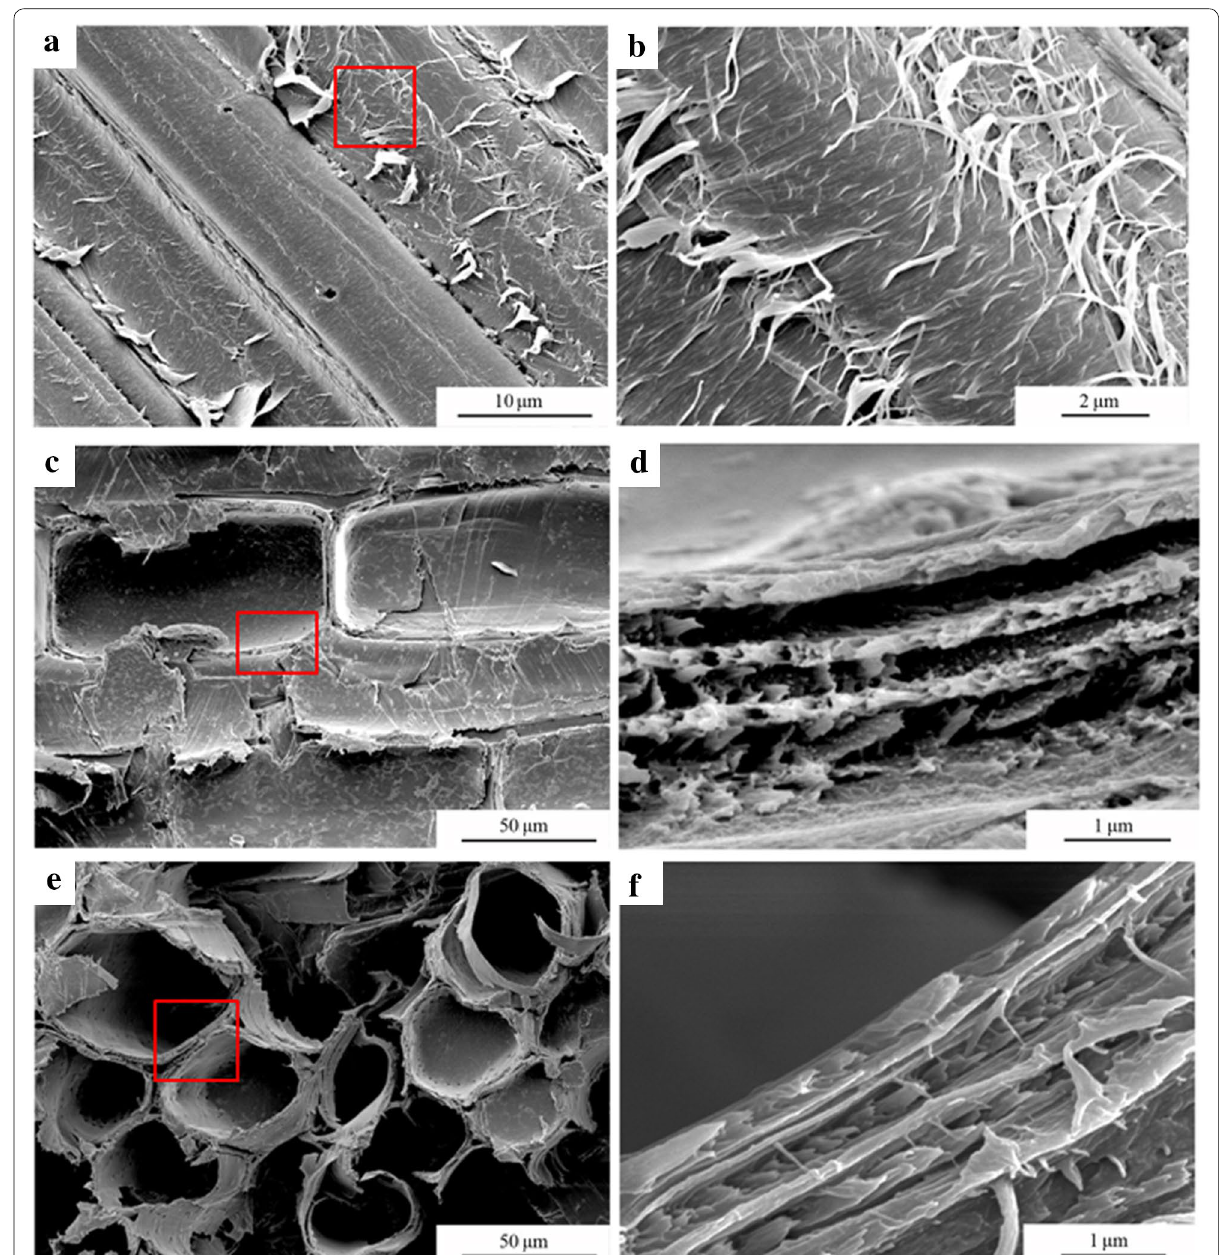
Fig. 6 Fracture morphology of bamboo fiber cells and parenchyma cells: a fiber cells, c long parenchyma cells, e short parenchyma cells, b , d and f are amplifications of the marked areas corresponding to a , c and